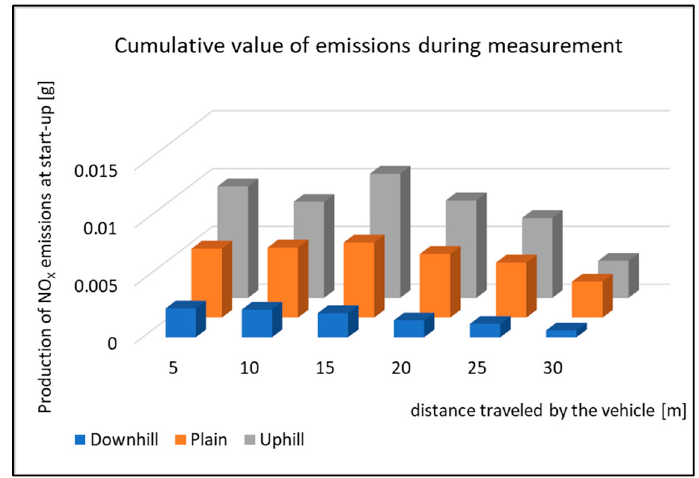
Figure 18. Cumulative value of Nox emissions during measurement.